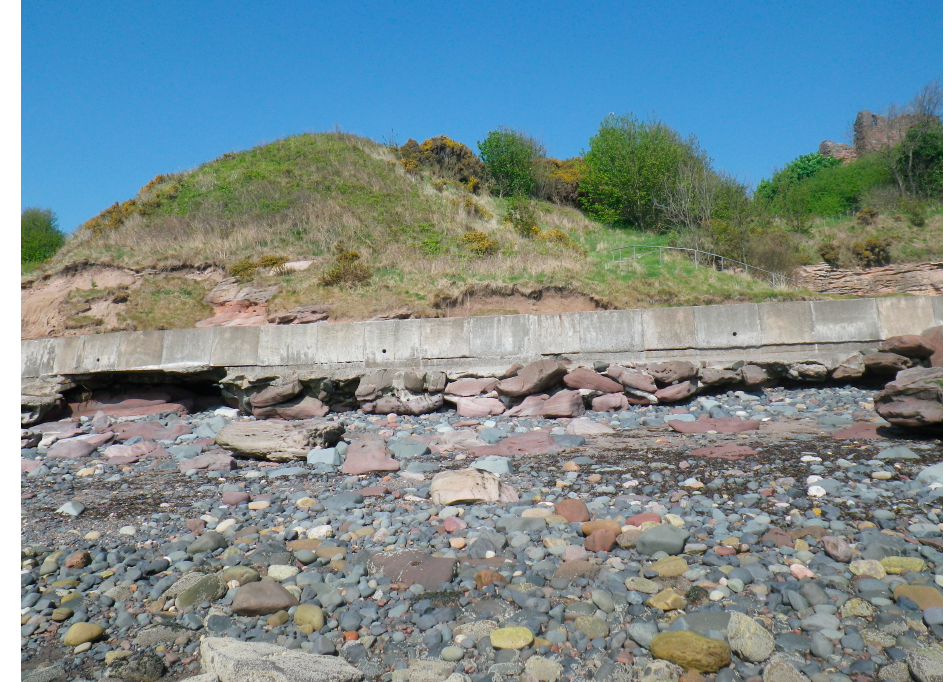
Figure 7. Failed coastal defence at Wemyss caves.